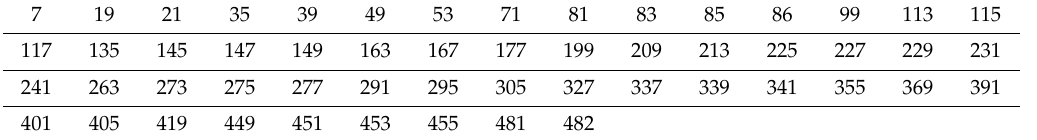
Table 12. x2 and x3 corresponding to block P texture template (decimal).